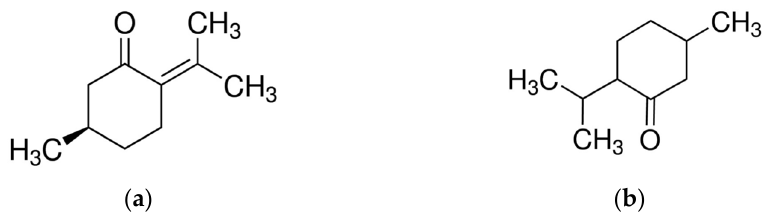
Figure 6. Main components of Minthostachys verticillata EOs. ( a ) Pulegone; ( b ) Menthone. Lower concentrations were needed to inhibit most of the Gram-positive bacteria than sensitive than